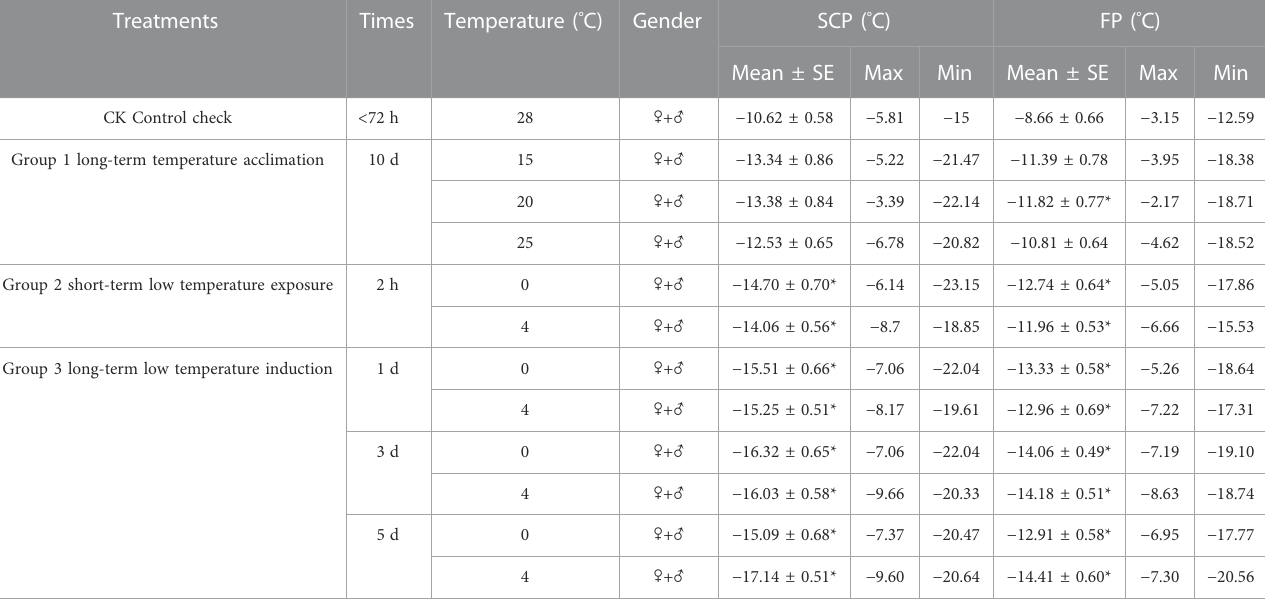
TABLE 1 Supercooling point and freezing point of female and male adults of Megabruchidius dorsalis at different treatments.